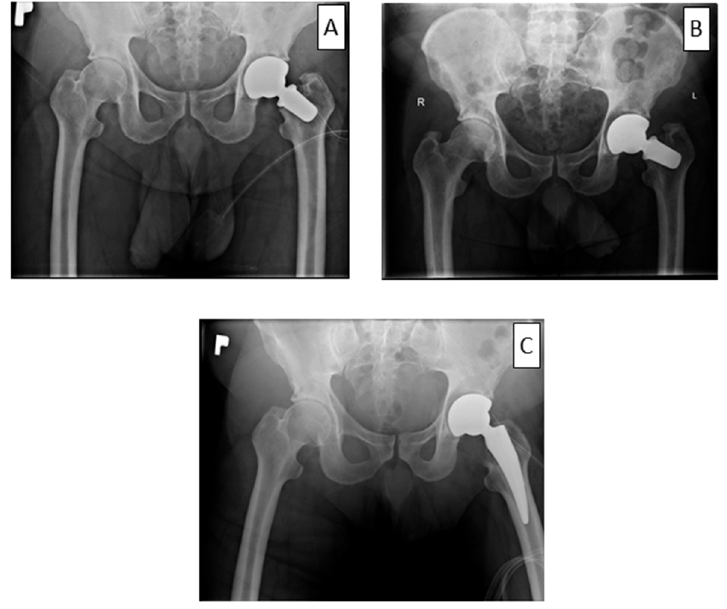
Figure 4. The case of early loosening from the short-stem group. X-ray taken after implantation ( A ), loosening 4 weeks after implantation ( B ) and after revision surgery ( C ).